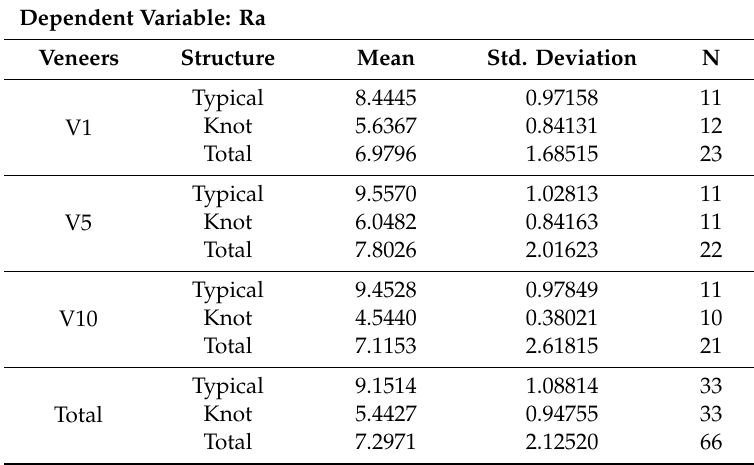
Table 1. Descriptive statistics of dependent variable Ra measured on oak veneers of typical and non-typical structure around the knot.